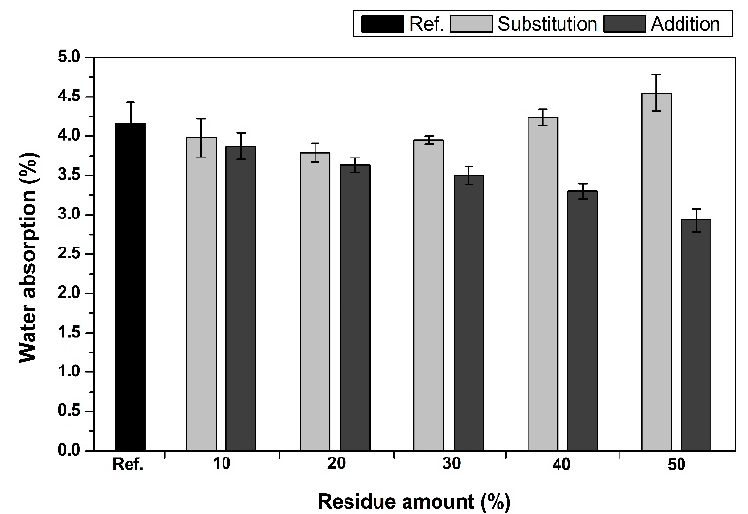
Figure 6. Water absorption of the concretes at 28 days.